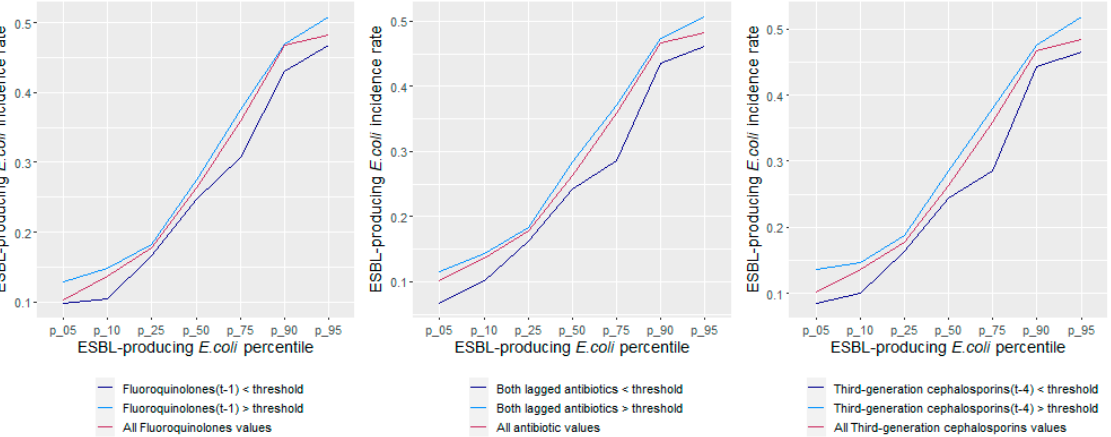
Figure 5. The cumulative ESBL-producing E. coli incidence rates relative to fluoroquinolone and third-generation cephalosporin use being above or below their respective thresholds.